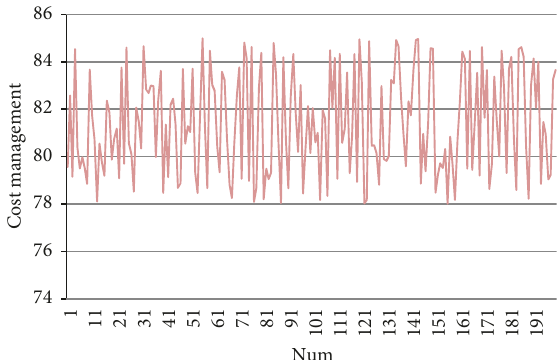
Figure 16: Effect verification of the whole-process cost manage- ment system of construction projects based on